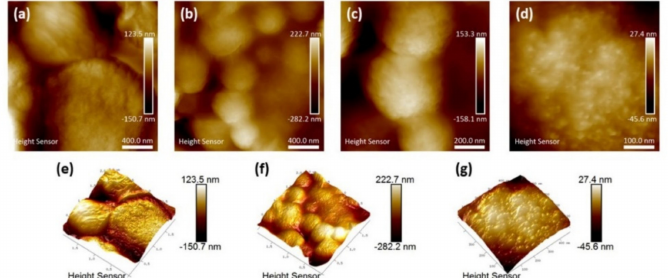
Figure 3. Atomic force micrographs of titania nanoshells. ( a ) Micrographs of a few larger nanoshells. ( b ) An aggregate of smaller nanoshells average diameter is 420 nm (SD = 80 nm). ( c ) Magnified